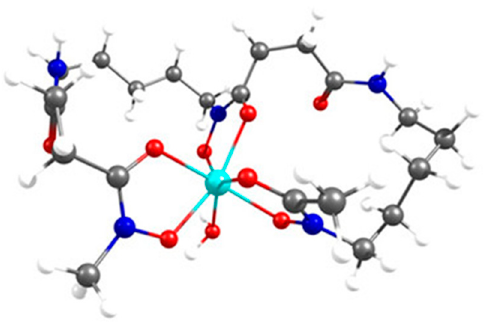
Figure 9. Structure of the DFT optimized geometric isomer of the seven-coordinate [Zr(DFO)(H 2 O)] + complex in N-cis-cis orientation. Reprinted (adapted) with permission from [28]. Copyright {2020} American Chemical Society.